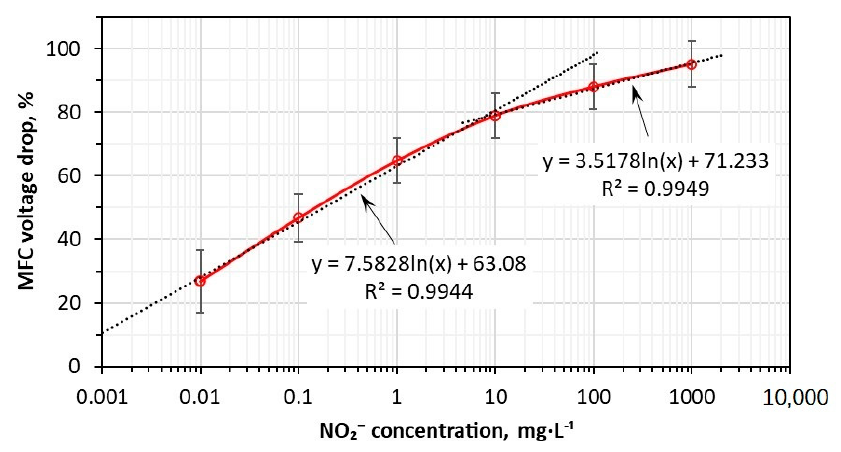
Figure 6. Dependence of microbial fuel cell (MFC) voltage drop on the concentration of nitrite ions in contaminated anolyte-model wastewater.